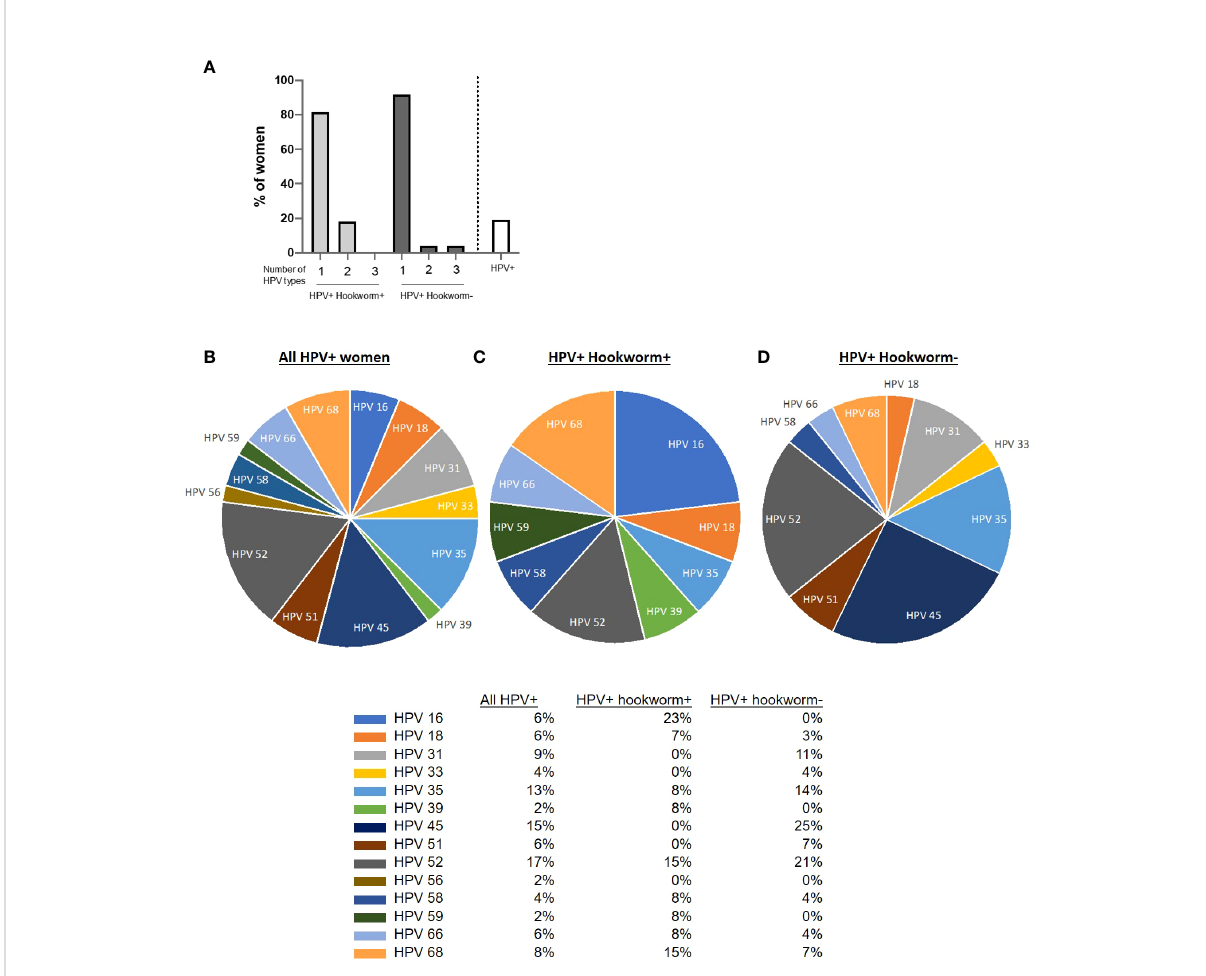
FIGURE 3 HPV distribution in the cohort. (A) Overview of women infected with one or multiple HPV subtypes in the cohort and percentage prevalence of HPV in the cohort. (B – D) Pie chart showing the proportion of women positive for the different HPV types tested. Each slice of the pie represents the total percentage of women in each category of